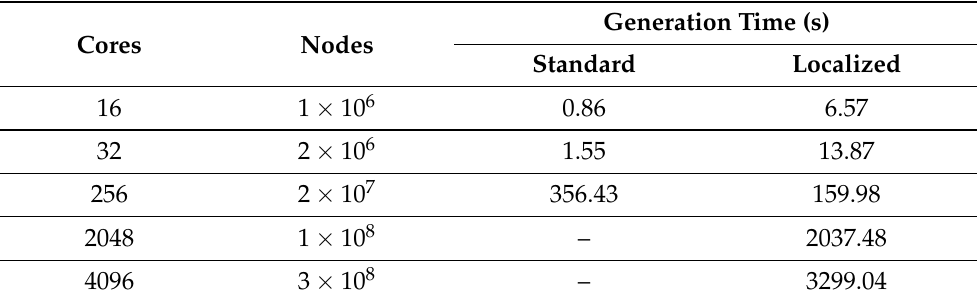
Table 2. Weak scalability analysis for the random-field generation on Occigen cluster. Standard: wall-time required to generate a single random field over the entire domain. Localized: wall-time required to generate the random field with the localized approach mentioned in the